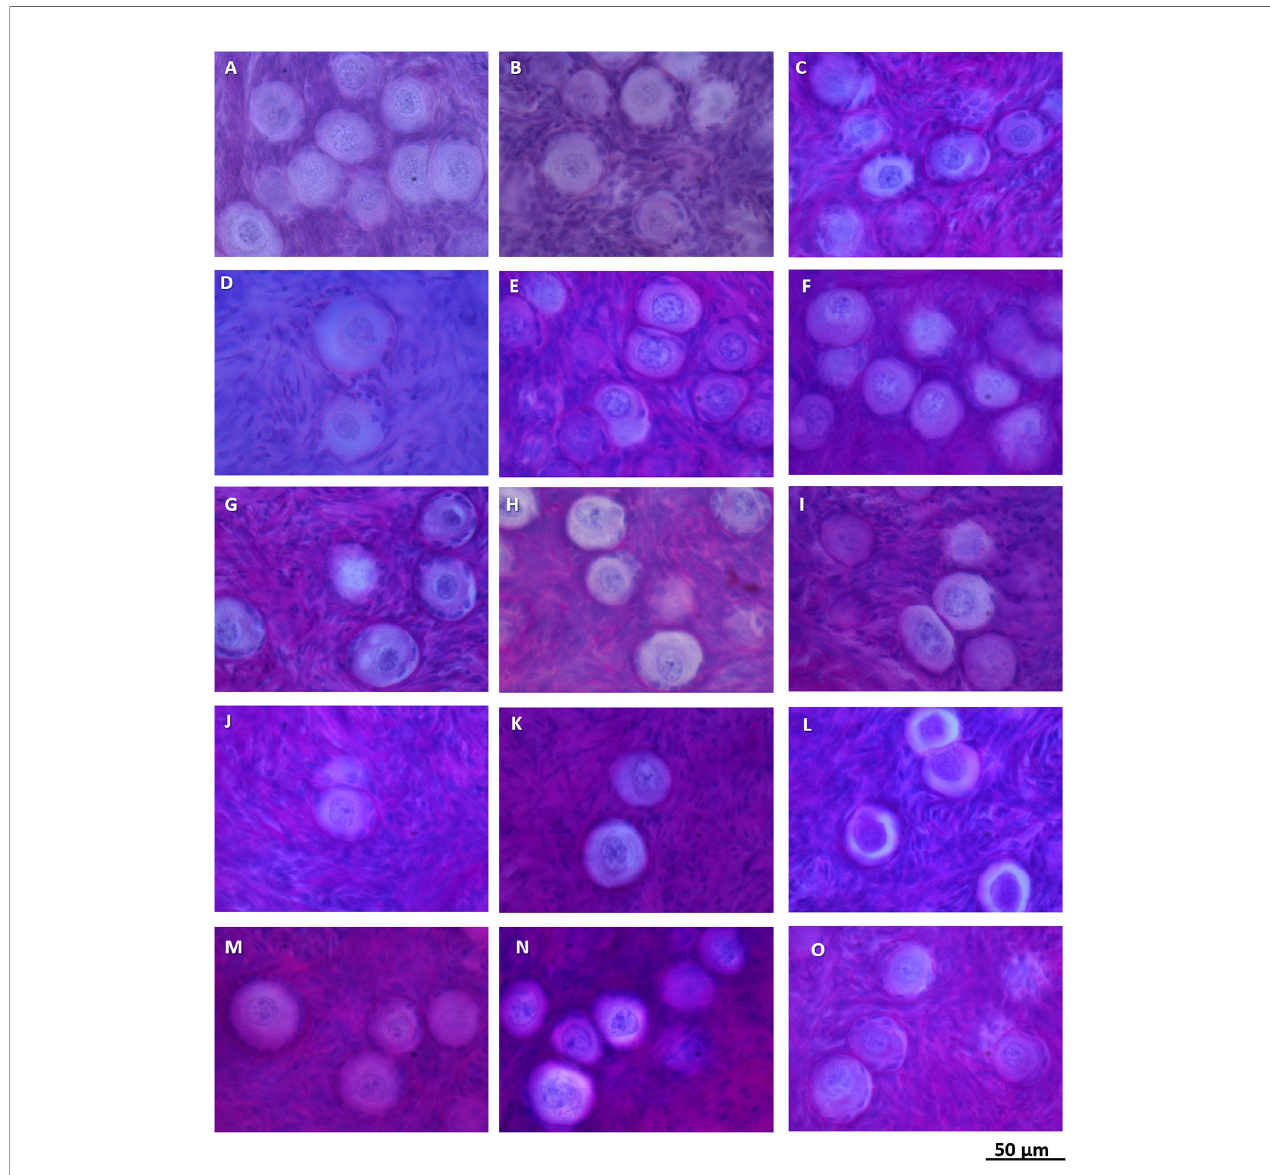
FIGURE 1 | Normal follicle morphology in ovarian cortex in girls with b -thalassemia (A – L) and sickle cell disease (M – O)